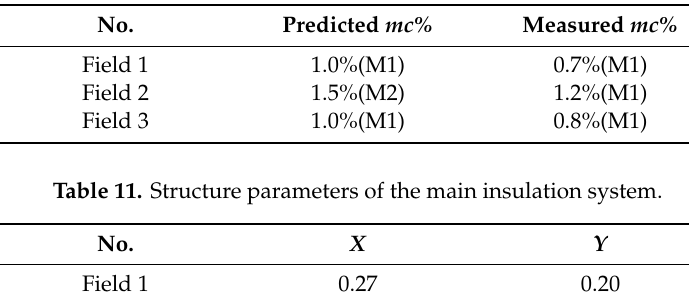
Table 10. Prediction results of field transformers.